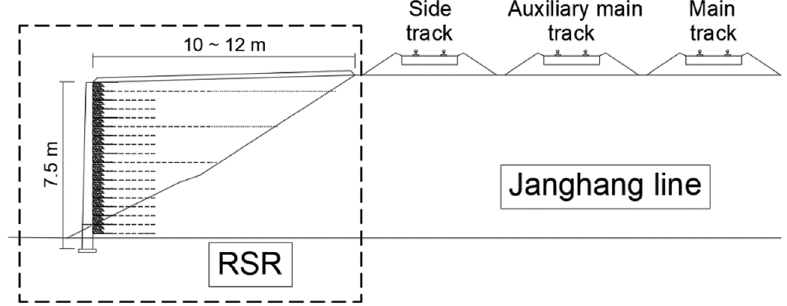
Figure 4. Section view when applying RSR on the Janghang line.